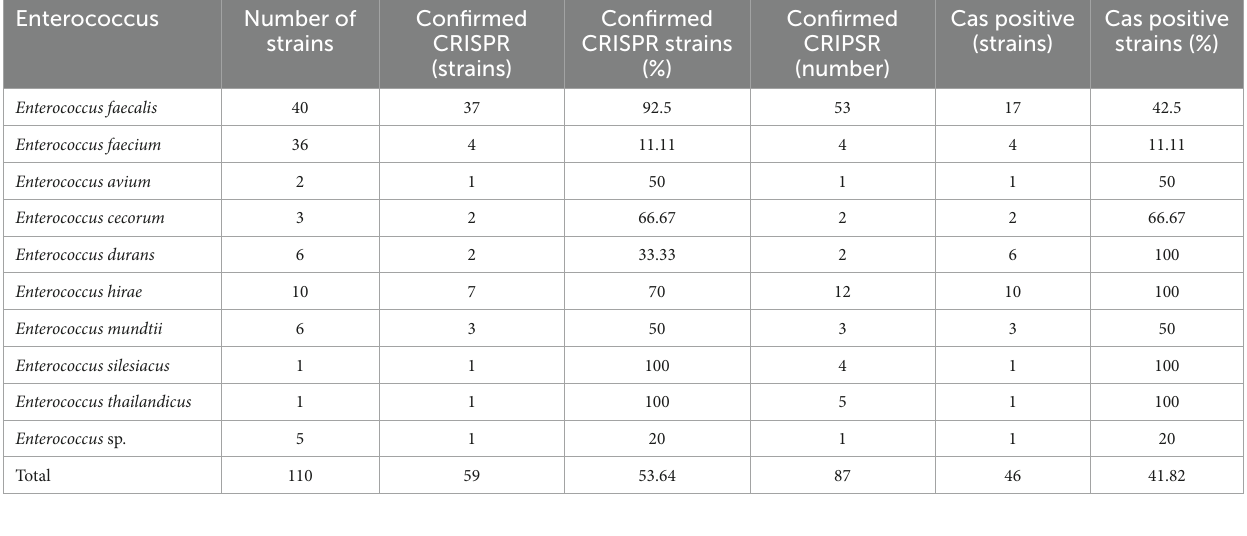
TABLE 1 Distribution of CRISPR-Cas system in 110 strains of Enterococcus .